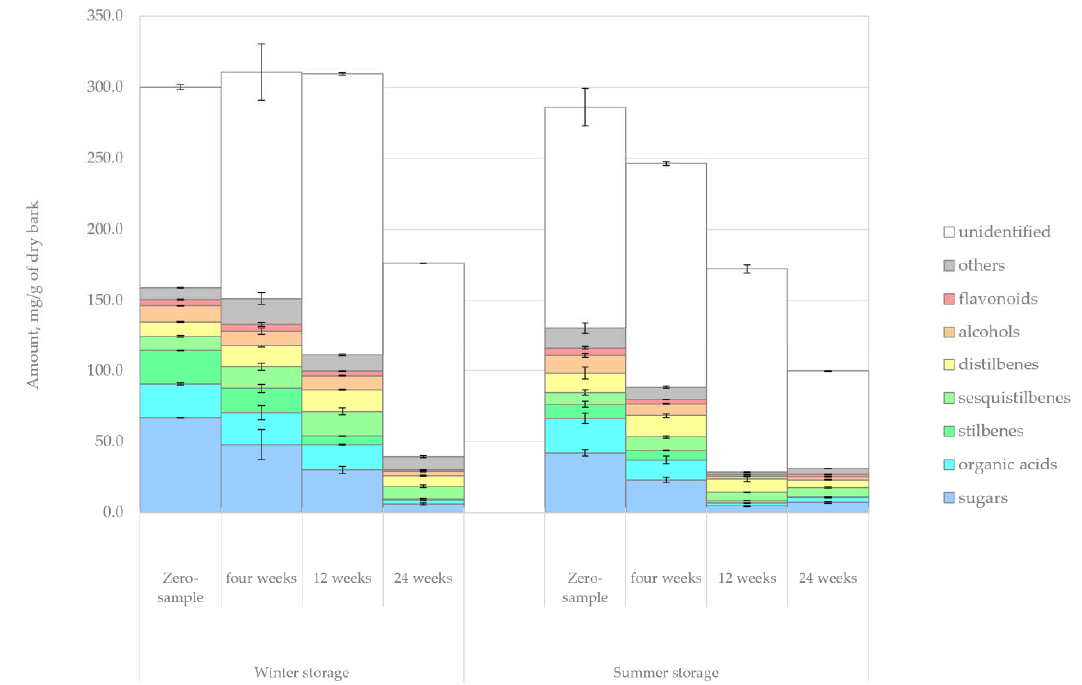
Figure 5. Changes in the amount of hydrophilic compounds (mg/g of dry matter) in saw log bark during summer and winter storage periods. The identification of the extractives group sesquistilbenes is conjectural. It is also possible that this group should be identified as sesquilignans.